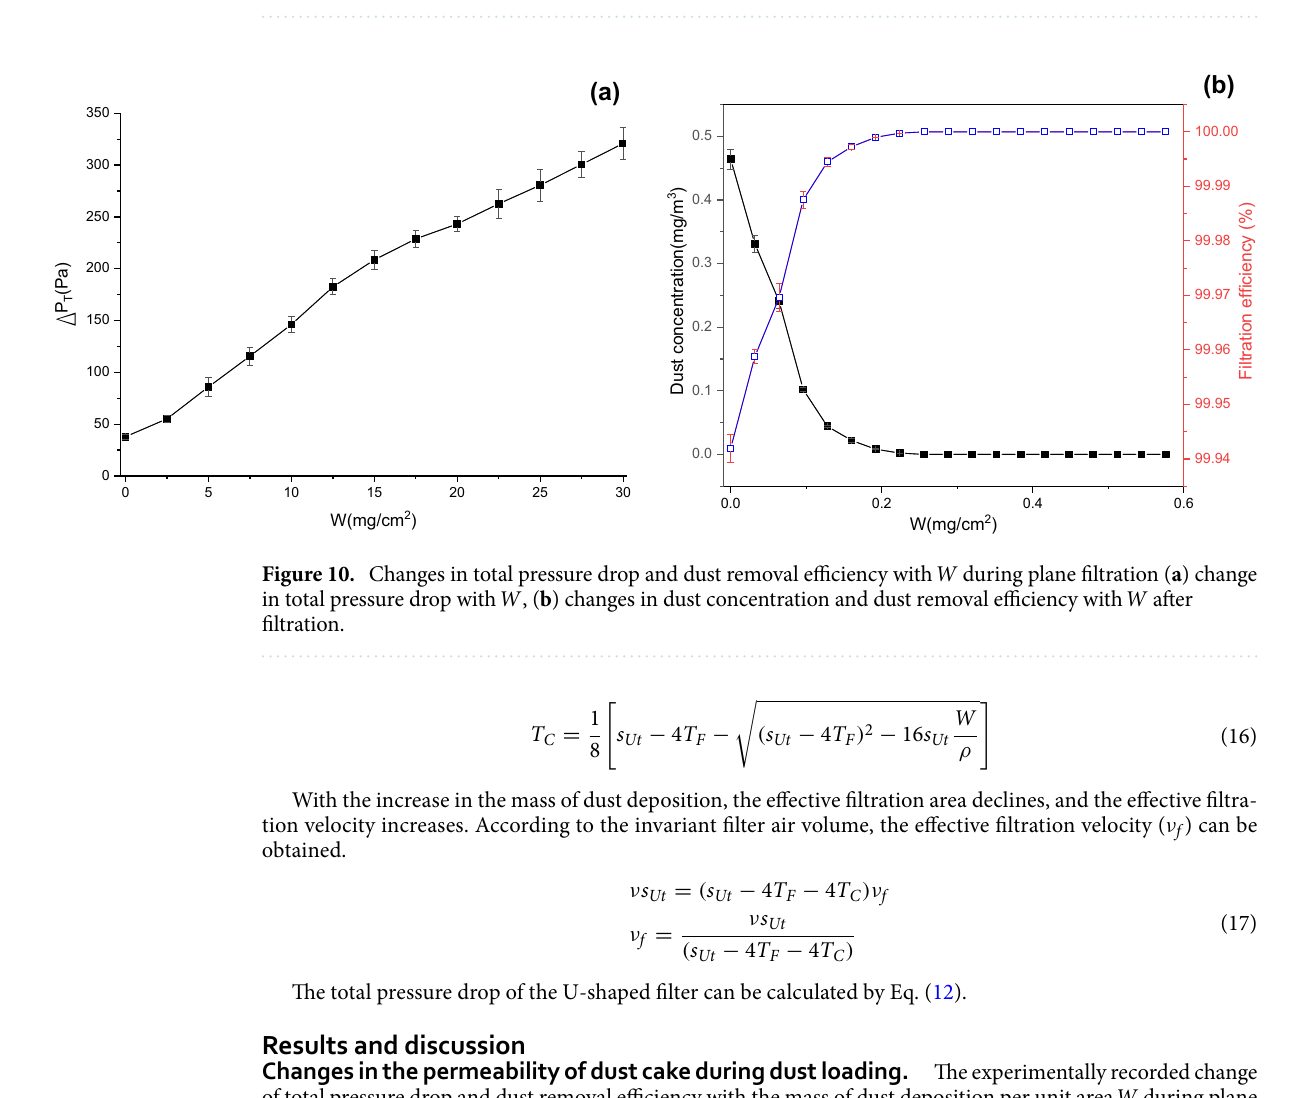
Figure 9. dust deposition on the U-shaped filter.